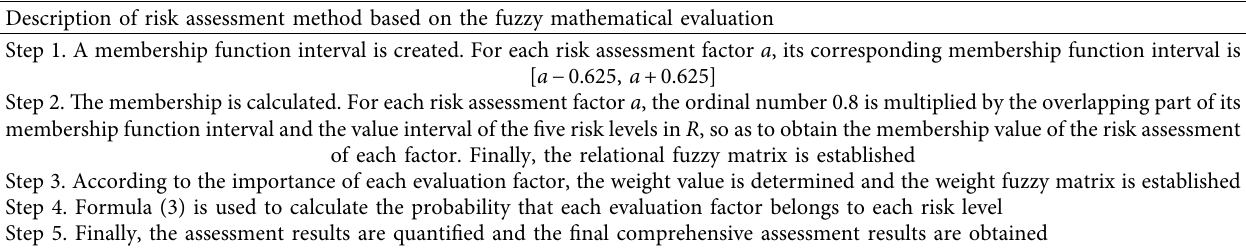
Table 2: Risk assessment method based on the fuzzy mathematical evaluation.